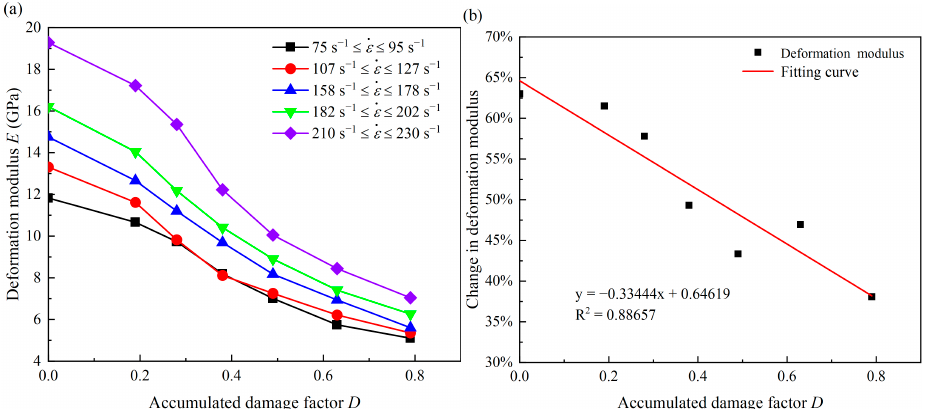
Figure 19. Variation in ( a ) the deformation modulus of sandstone and ( b ) change in deformation modulus with accumulated damage.